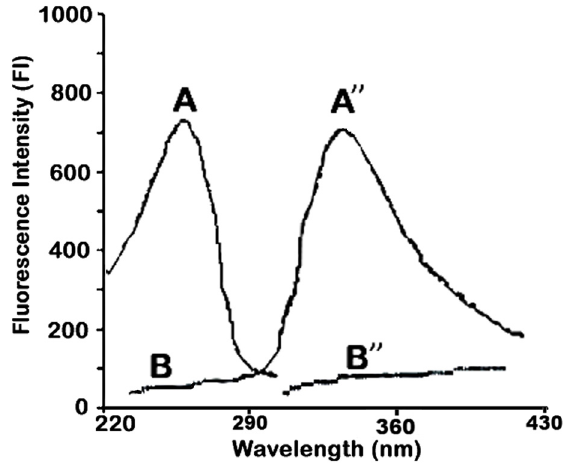
Figure 2: Fluorescence spectra of 200.0 ng/mL of SOT in water. (A, A”): Excitation and emission spectra of SOT, (B, B”): Excitation and emission spectra of water.